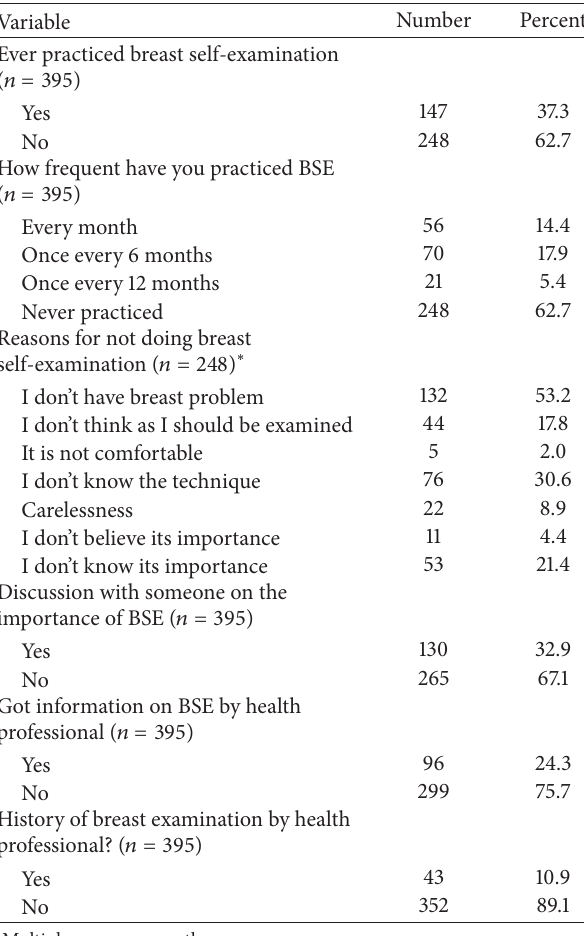
Table 3: Breast self examination practice among HCWs in West Gojjam Zone, Northwest Ethiopia, October